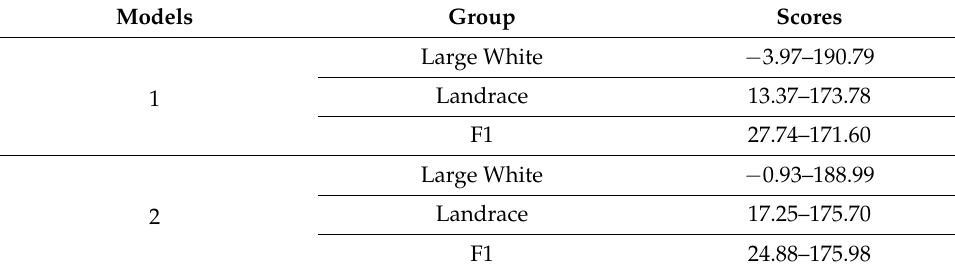
Table 14. Range of the estimated index scores.